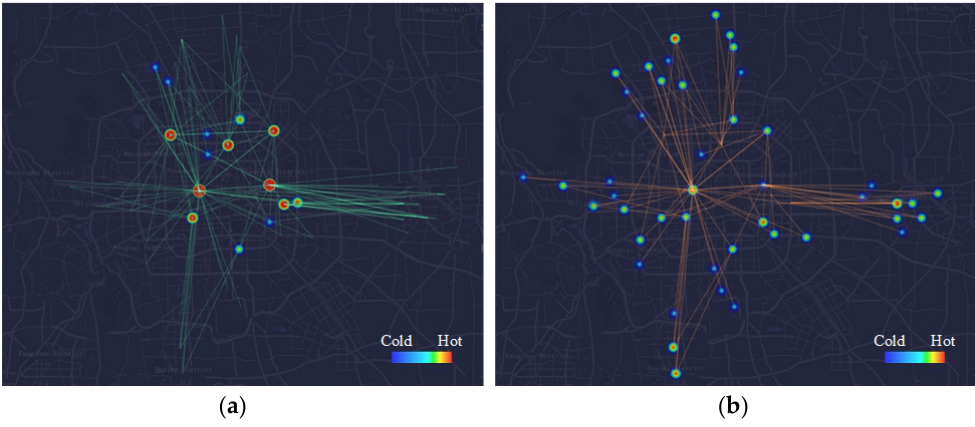
Figure 9. CB routes of the potential scheme. ( a ) Morning peak hours; ( b ) Afternoon peak hours. Table 2. Beijing CB network contrast.